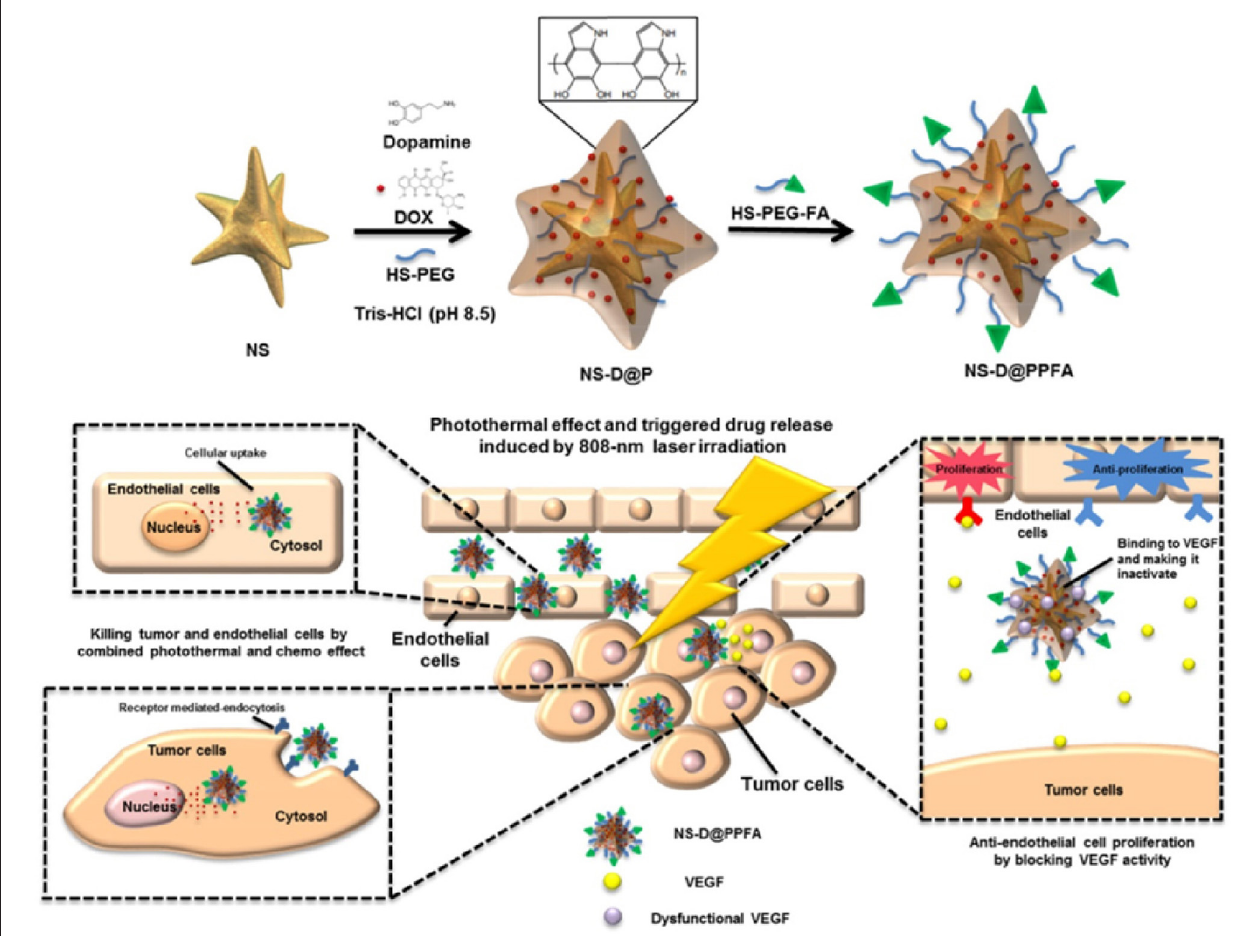
FIGURE 10 | Gold nanostars (GNS) modified with folic acid and thiolated polyethylene glycol (PEG) for targeted cancer therapy. GNS coated with dopamine can facilitate doxycycline (DOX)-loading and are modified with targeting ligands for near-infrared (NIR)-triggered drug release and photothermal chemotherapy. Reproduced with permission from You et al. (2019) under copyright Creative Commons Attribution 4.0 International License (CC-BY license)